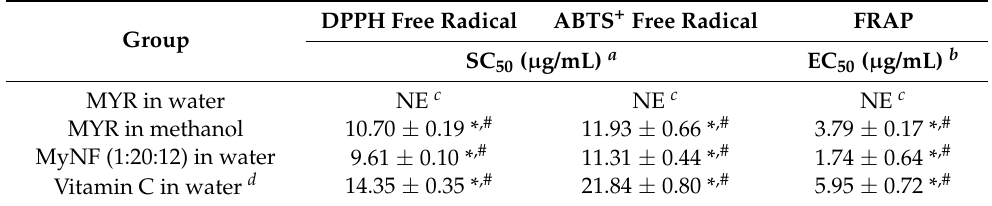
Table 3. The DPPH, ABTS + free-radical scavenging, and reducing power of MYR in water, MYR in methanol, MyNF (1:20:12) in water, and vitamin C in water. DPPH Free Radical ABTS + Free Radical FRAP Group SC 50 ( µ g/mL) a EC 50 ( µ g/mL) b MYR in water NE c NE c NE